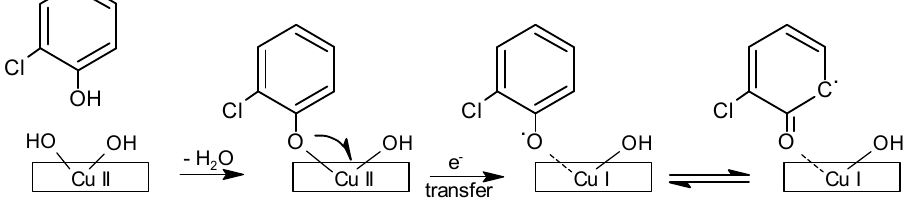
Figure 2. Interaction of a pollutant with a metal oxide cluster. In this representation, monochlorphenol is chemisorbed to the surface of the particle by the elimination of a molecule of water. A 1-electron transfer then results in Cu II reduction to Cu I and the formation of a surface-stabilized, oxygen-centered radical. It is resonance with a carbon-centered radical(s) on the ring further stabilizes the radical.